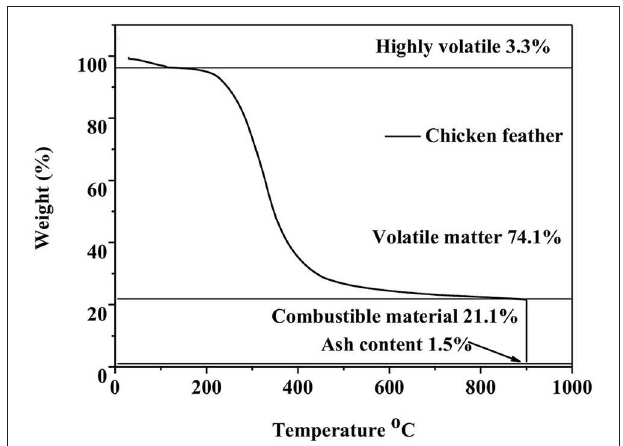
FIGURE 1 | Ash content measured by TGA